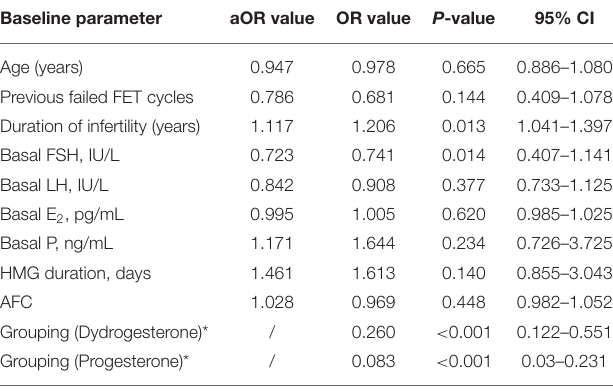
TABLE 4 | Logistic regression of pituitary LH